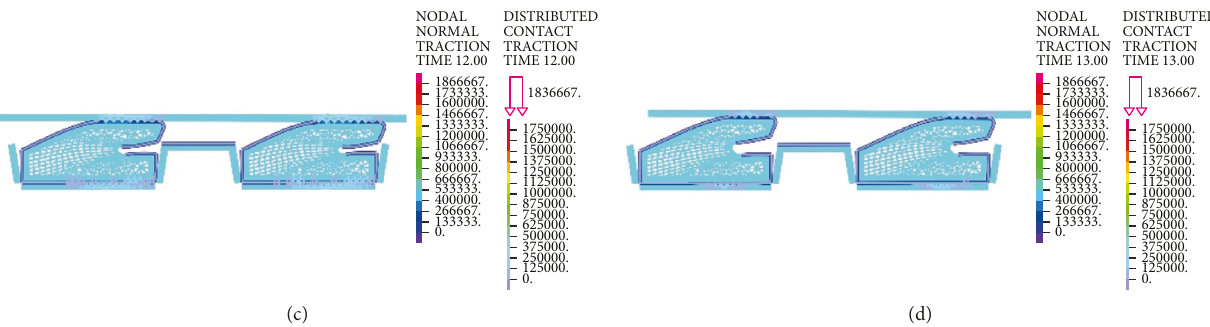
Figure 24: Contact stress distribution of the rubber rings after optimizing during anticlockwise rotation. (a) Deflection 0.2 ° . (b) Deflection 0.4 ° . (c) Deflection 0.6 ° . (d) Deflection 0.8 ° .